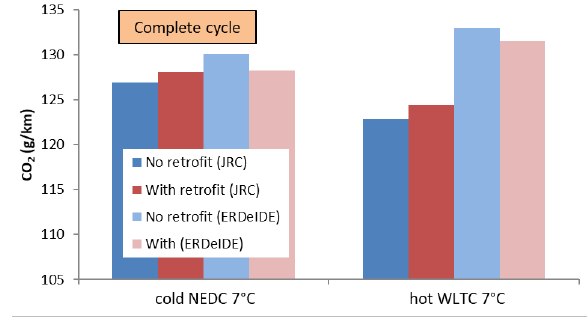
Fig. 2. CO 2 results for the complete cycles